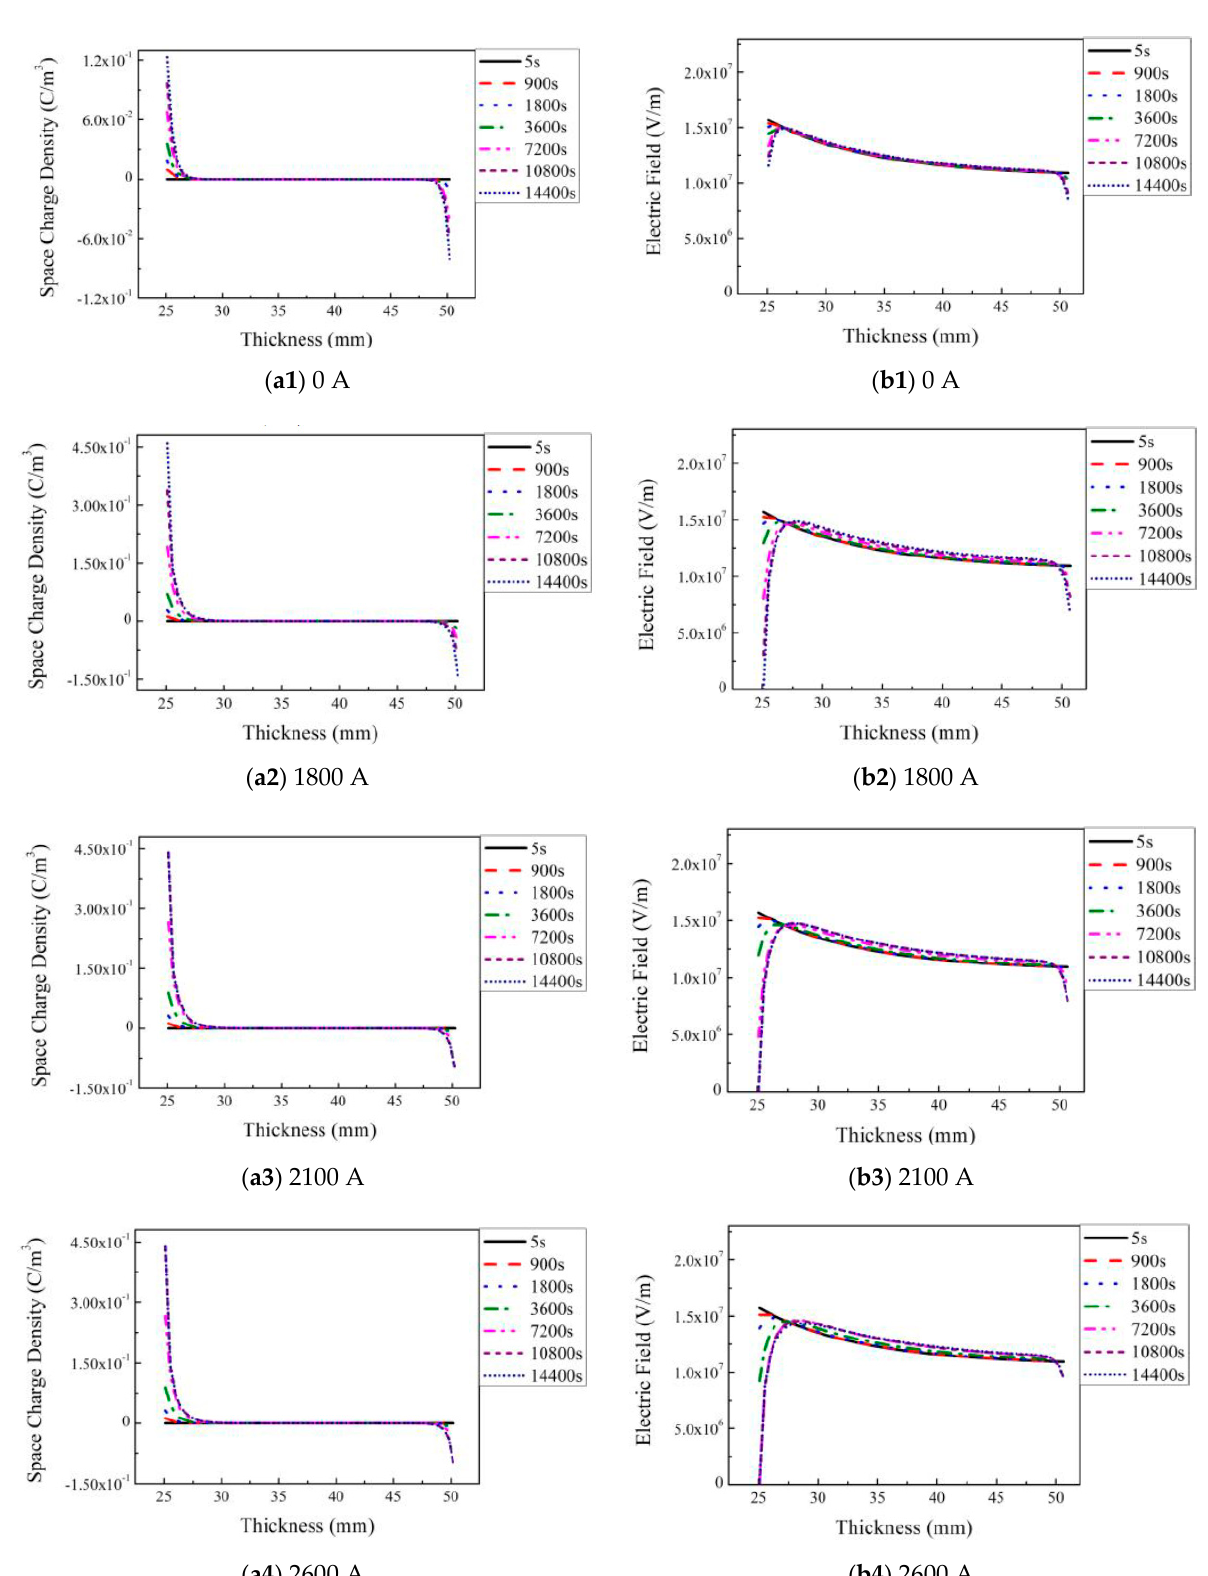
Figure 11. Simulation results of space charge distribution( a1 - a4 ) and electric field distribution( b1 - b4 ) in HVDC insulation when the trap density is 1000 × 10 19 m − 3 , trap depth is 1.20 eV with load current varying from 0 to 2600 A under 320 kV.